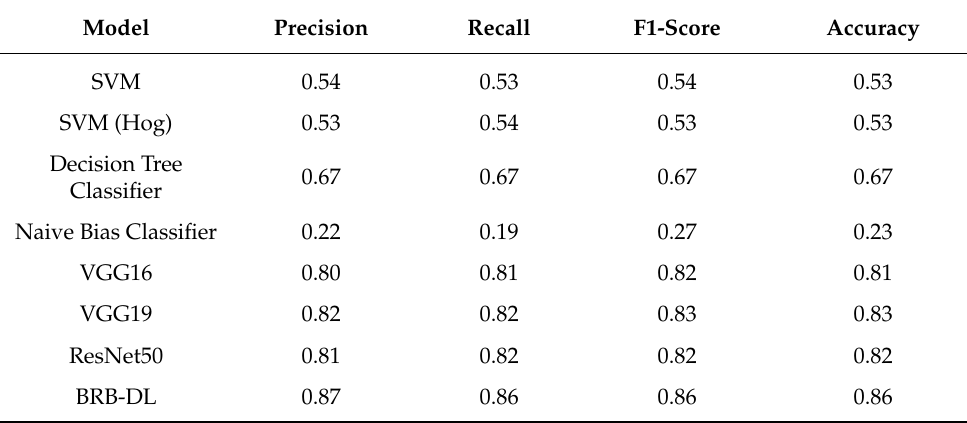
Table 10. Comparative evaluation of our proposed model against other